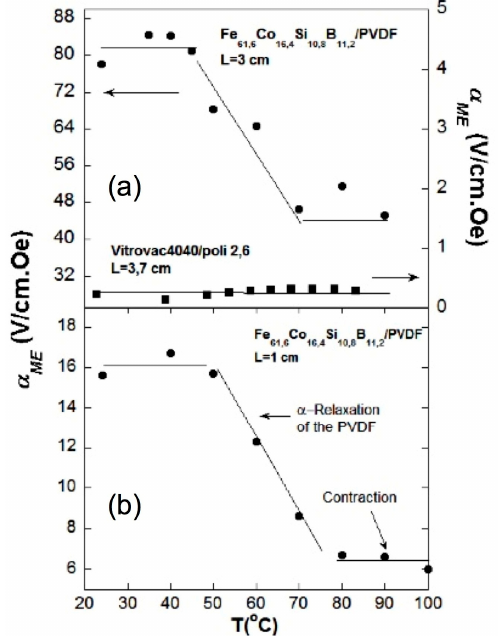
Figure 12. ( a ) Dependence of the magnetoelectric coefficient with temperature for (a) L = 3 cm Fe 61.6 Co 16.4 Si 10.8 B 11.2 /PVDF and L = 3.7 cm Vitrovac ® 4040/poli 2,6 laminated L-T composites; ( b ) L = 1 cm Fe 61.6 Co 16.4 Si 10.8 B 11.2 /PVDF laminated composite. All the measurements were carried out at the magnetoelastic resonance frequency of the laminates. Reprinted with permission of the authors from [15]. Copyright 2015 IEEE.